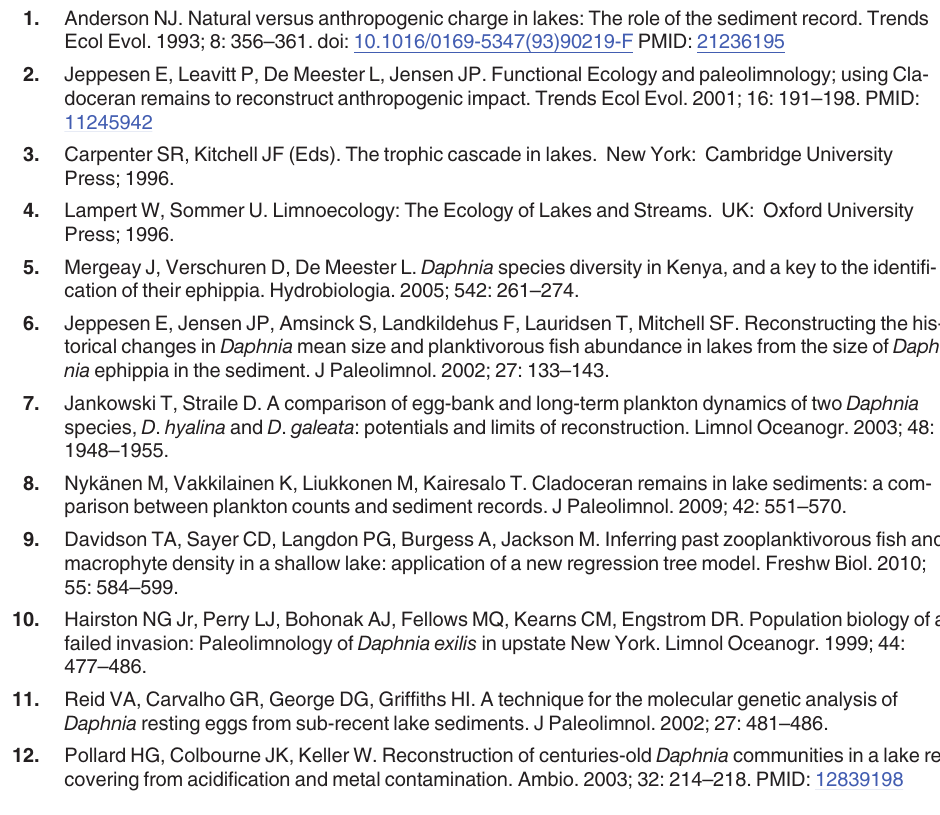
S1 Table. 210Pb and 137Cs analytical results of core A1 for